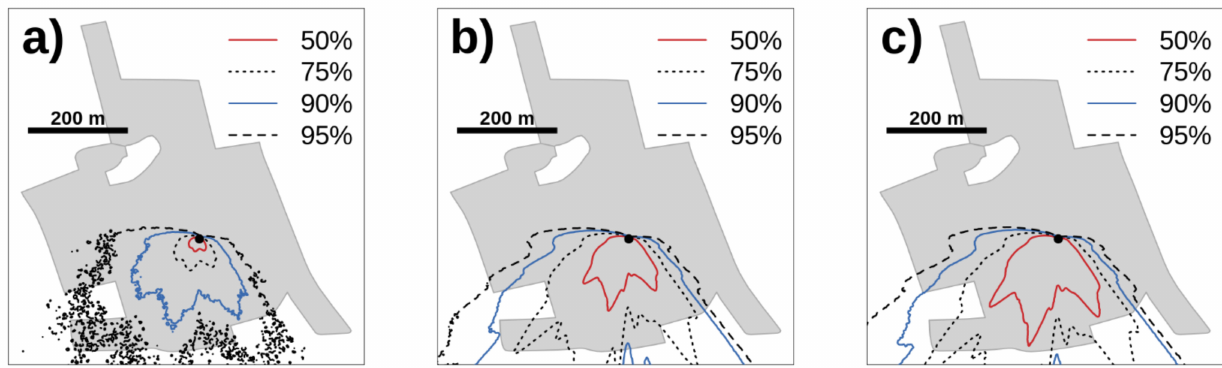
Figure 5. The lines represent the areas contributing to 50%, 75%, 90%, and 95% for ( a ) the flux footprint area, contributing to the flux measurement. The concentration footprint areas for ( b ) 1 m and ( c ) 2 m, contributing to the concentration measurements. Areas for the concentration footprints are approximated by assuming 100% of the contribution is within 750 m. The footprints are averaged over all measurement intervals in